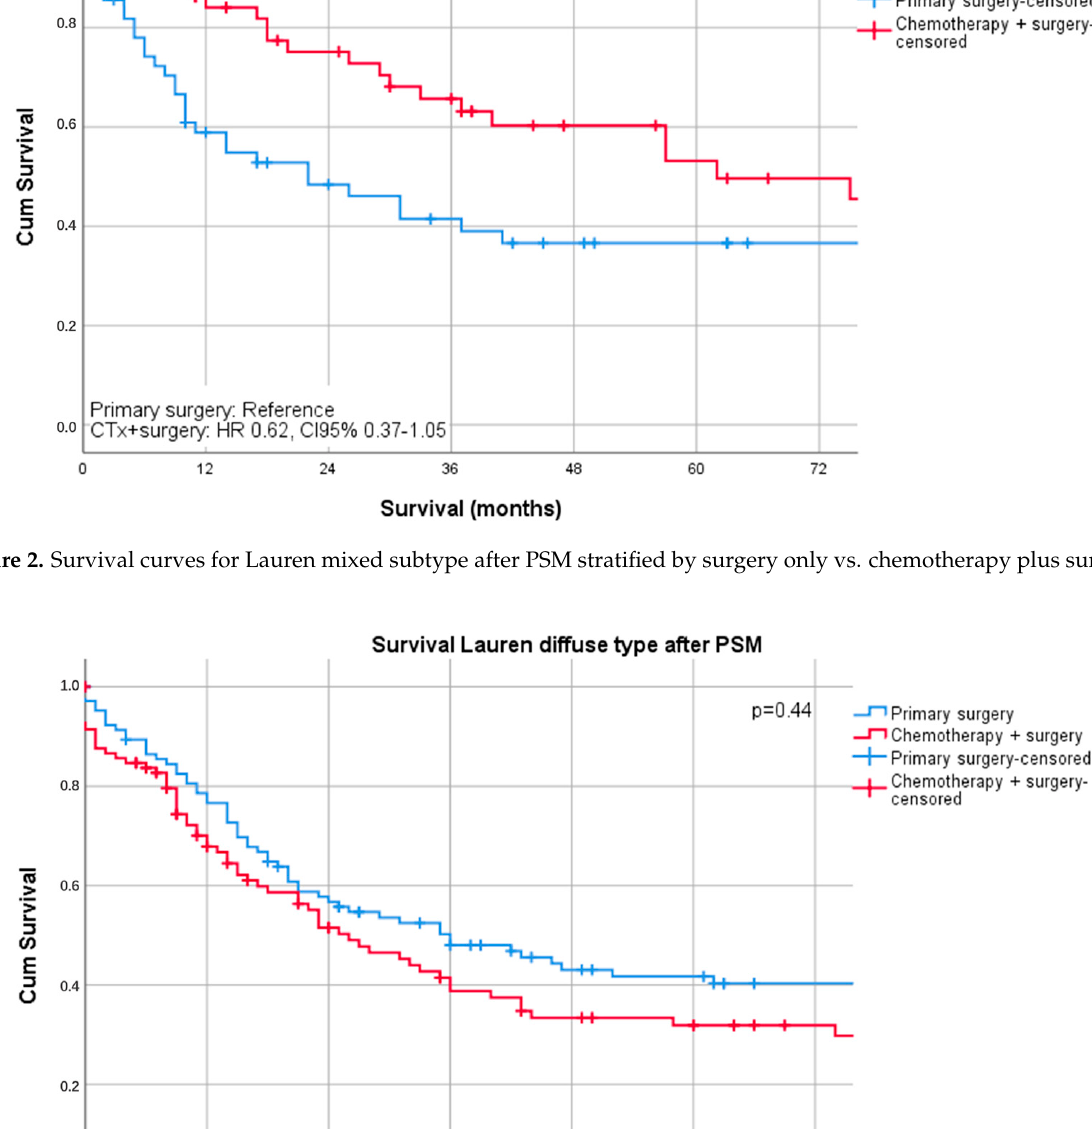
Figure 1. Survival curves for Lauren intestinal subtype after PSM stratified by surgery only vs. chemotherapy plus surgery.